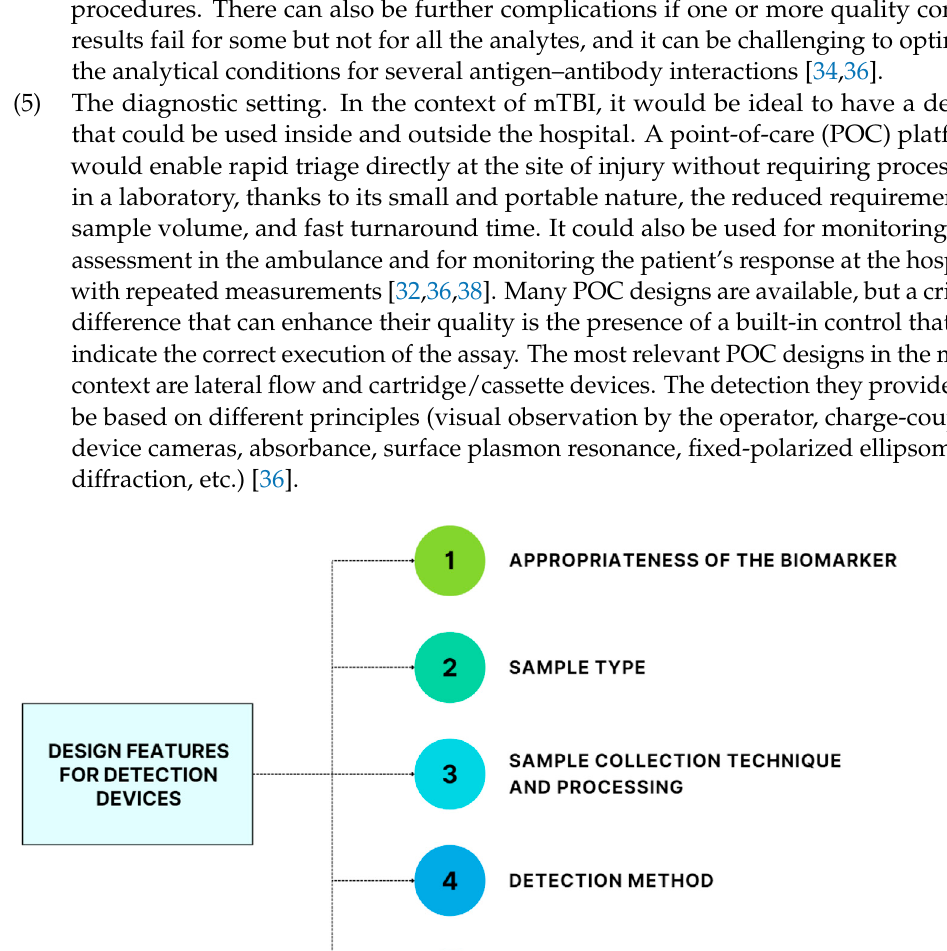
Figure 3. Current stage of development of detection devices for fl uid biomarkers. The measurement methods of early-stage devices are based on di ff erent detection methods: electrochemical detection, optical detection, surface-enhanced Raman spectros- copy (SERS), and surface acoustic wave (SAW) [39]. Electrochemical sensors use a three-electrode system (counter, working, and refer- ence electrodes) to convert chemical changes into electrical signals. In the case of mTBI biomarkers, the working electrode is functionalized with antibodies for the biomarker of interest or with an enzyme that converts the target biomarker into an electrically detecta- ble product, and the signal is measured using impedimetric, amperometric, or potentiom- etric techniques. This technology has already been used to quantify GFAP, NSE, S100B, and tumour necrosis factor- α (TNF- α ) [40,41].